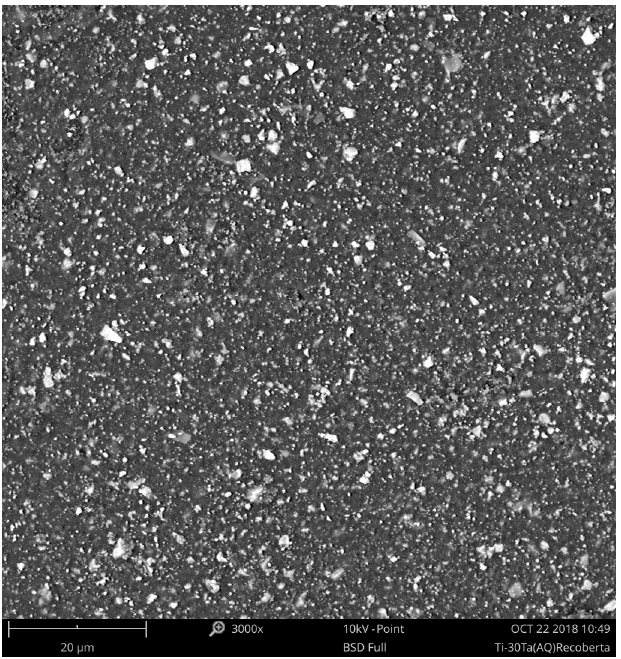
Figure 9. SEM of BaTiO 3 dispersion in the P(VDF-TrFE) matrix after the coating process.